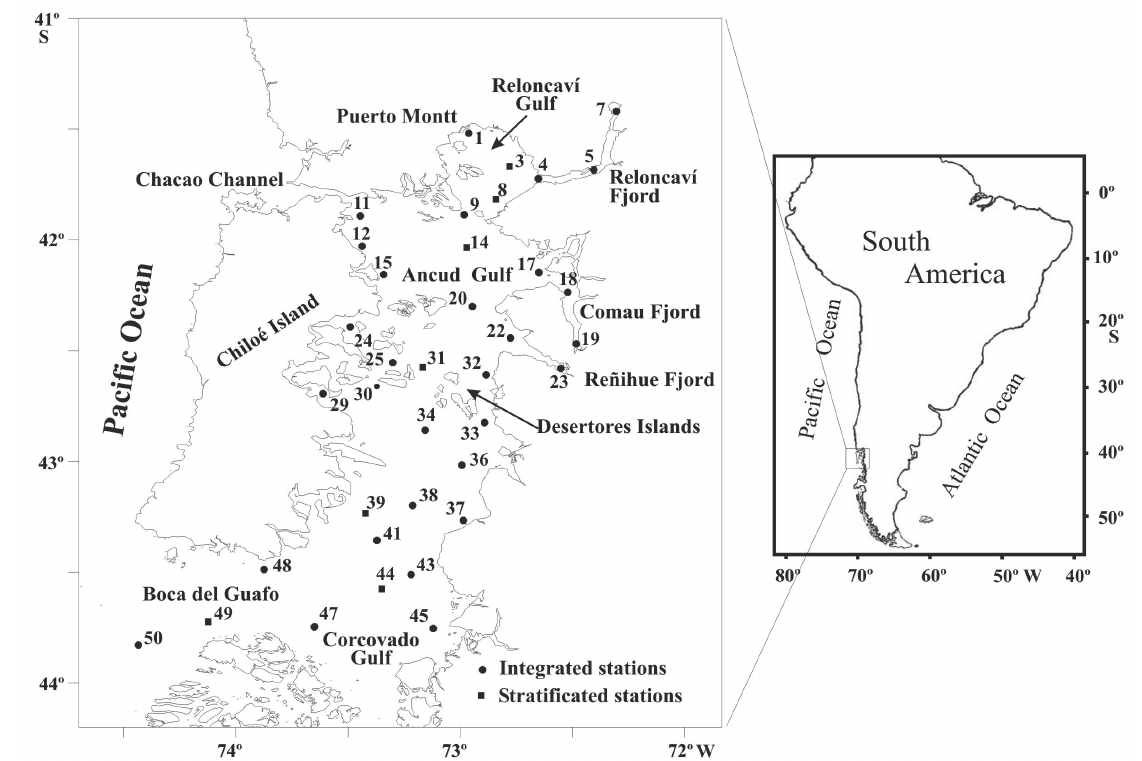
Fig . 1. – Geographic location of sampling stations in the inner waters of southern Chile (CIMAR 10 Fiordos